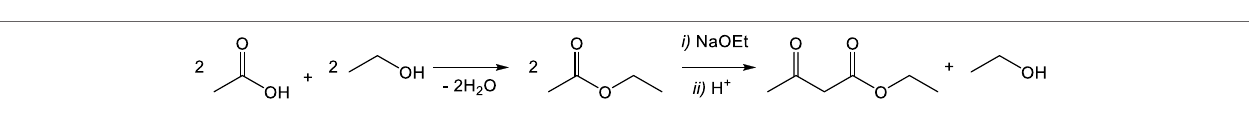
FigUre 5 | Esterification of acetic acid and Claisen condensation of ethyl acetate.